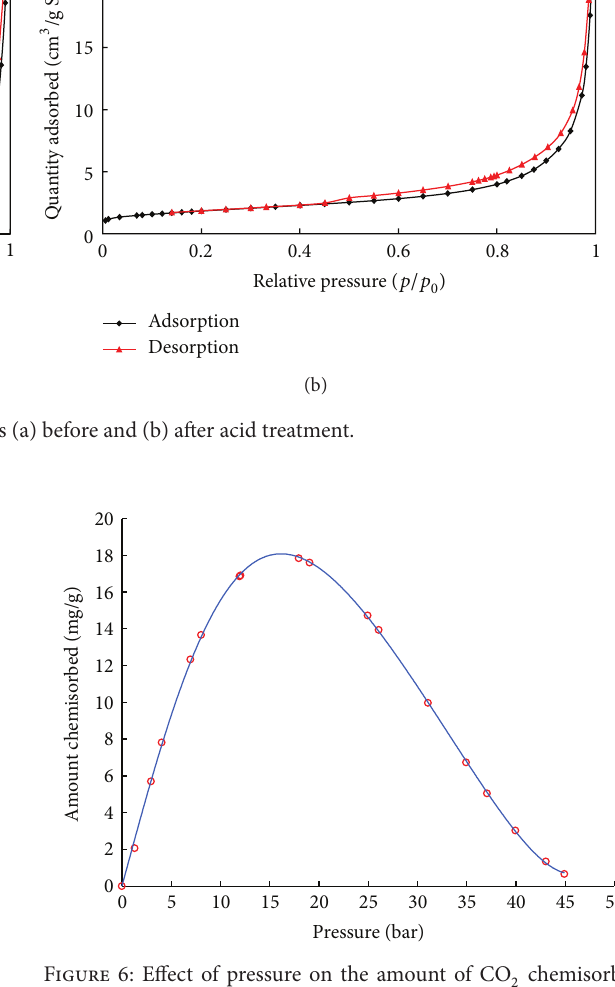
Figure 6: Effect of pressure on the amount of CO 2 chemisorbed onto treated